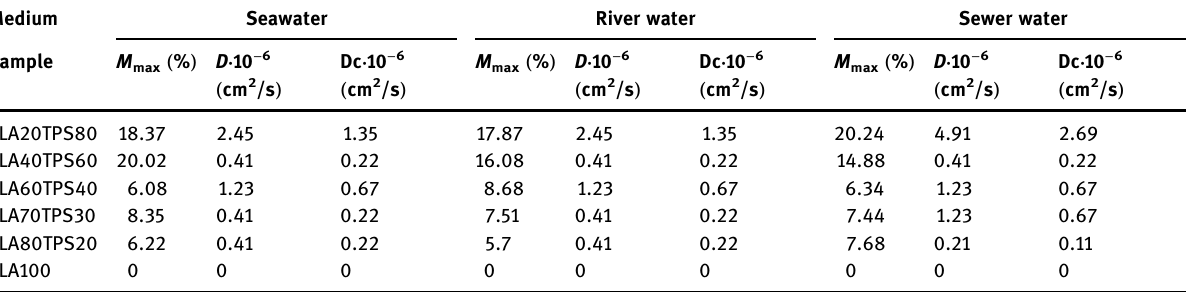
Table 5: Equilibrium water content ( M max ) , coe ffi cient of di ff usion ( D ) , and corrected coe ffi cient of di ff usion ( Dc ) of pristine PLA and PLA/TPS blend bionanocomposites within seawater, river water, and sewer water